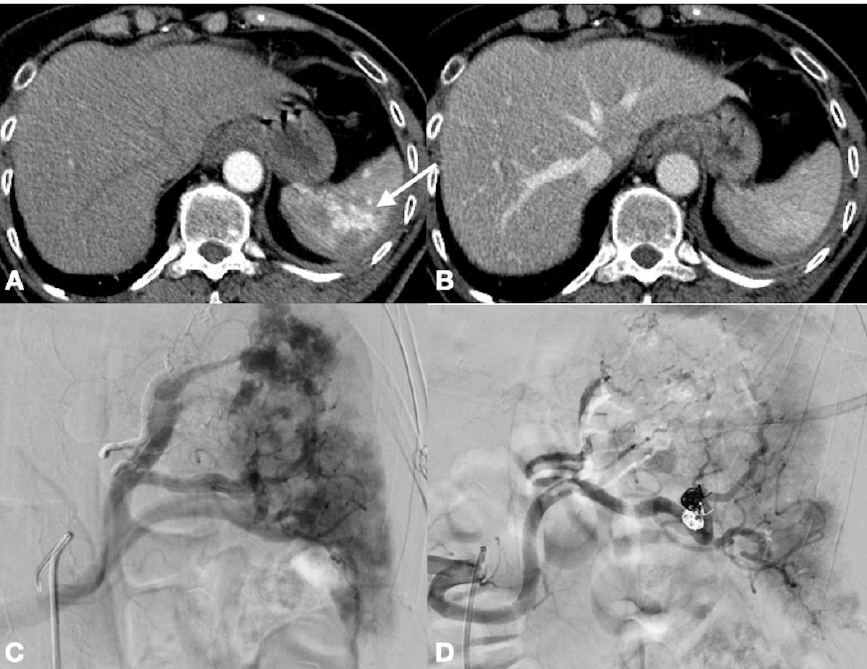
Figure 2. Enhanced-CT of a 56-year old male who sustained major trauma. Arterial ( A ) and portal venous phase ( B ). There is a small volume hemoperitoneum and multiple contained vascular injuries ( A , arrow) that can be seen only in the arterial phase. The patient underwent angiography which confirmed CT findings ( C ), followed by successful embolization ( D ).